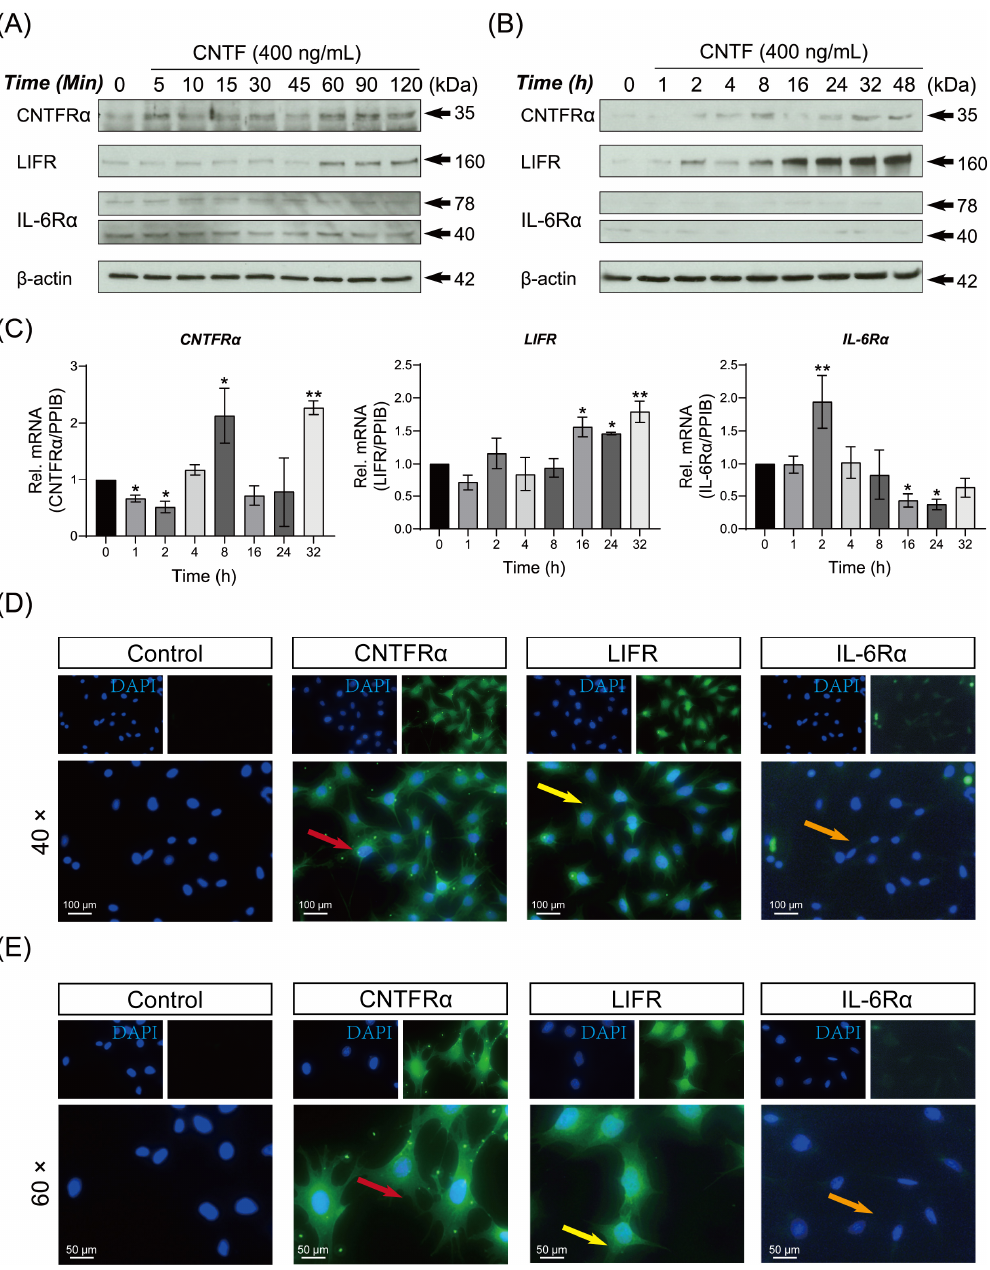
Figure 1. The tripartite CNTF-receptor complex is up-regulated by ciliary neurotrophic factor in cementoblasts. ( A , B ) WB showed protein expression of the CNTF-receptors (CNTFR α , LIFR and IL-6R α ) in OCCM-30 cells induced by CNTF protein (400 ng/mL) for various periods. Internal β -actin serves as loading control. ( C ) The expression of mRNAs encoding the CNTF-receptors were quantified by RT-qPCR. The relative mRNA expression of each gene was obtained through normalizing to internal PPIB . The statistical significance was determined by student t -test ( n = 3 for each group). ( D , E ) The CNTF-receptors immunofluorescent localization showed the expression of CNTFR α (red arrow), LIFR (yellow arrow) and IL-6R α (orange arrow) in CNTF-treated OCCM-30 cells. Nuclei are stained with DAPI (blue). Scale bar: 100 μ m (image magnification: 40×); 50 μ m (image magnification: 60×). Bar indicates values ± standard deviation (SD) which represent three independent experiments. Statistically significant differences (indicated by asterisks) are shown as follows (* p < 0.05; ** p < 0.005).